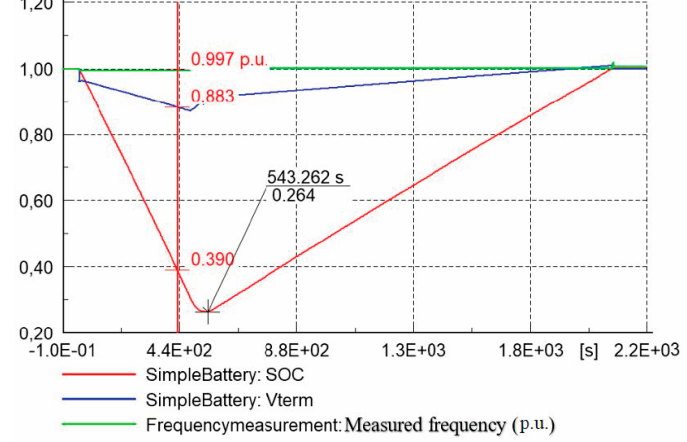
Figure 6. Results of simulation of discharge and charge of ESS.